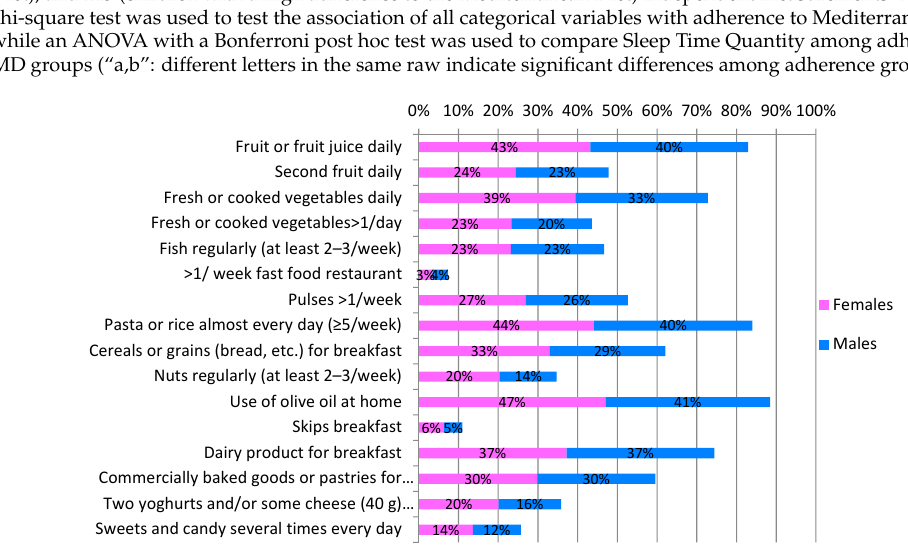
Figure 1. Responses to the KIDMED questionnaire of all children and by gender (percentage in respect to the total